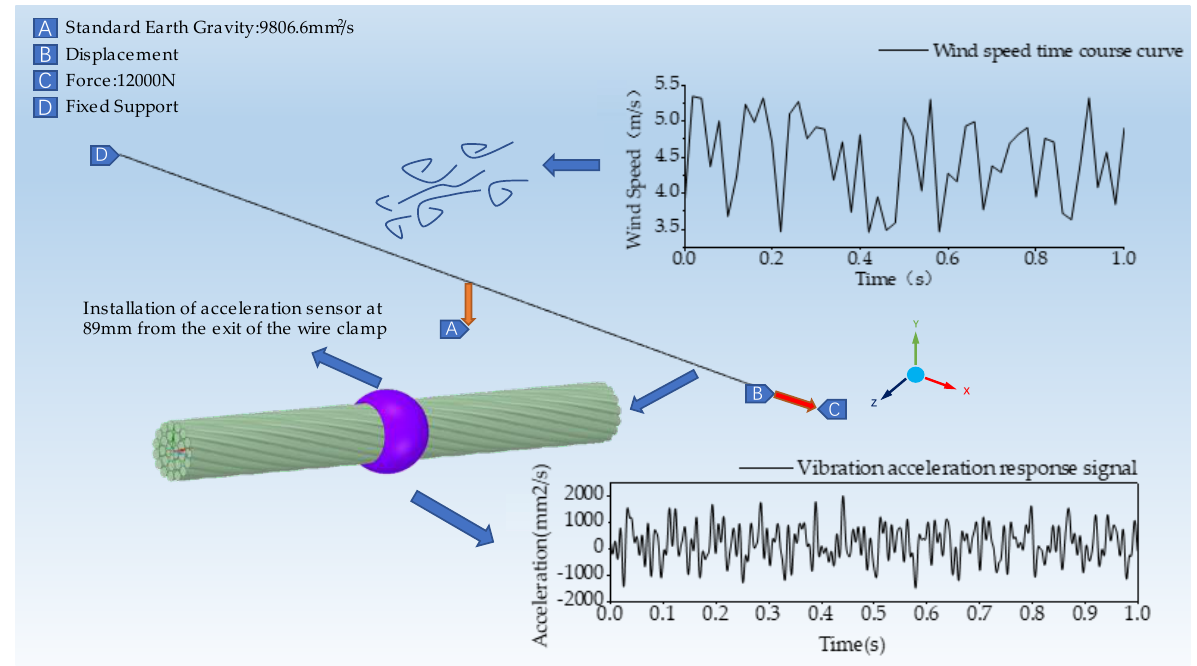
Figure 3. Simulation system model.